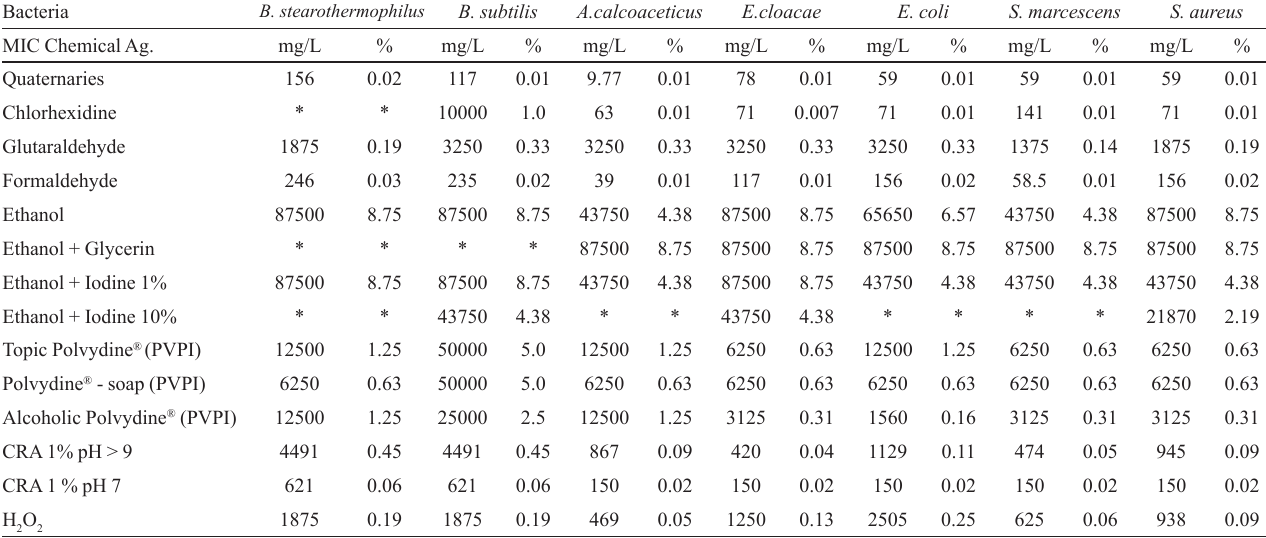
TABLE I – Minimum inhibitory concentration (MIC) of disinfecting chemical agents for strains tested face to microorganism suspensions (> 6 log 10